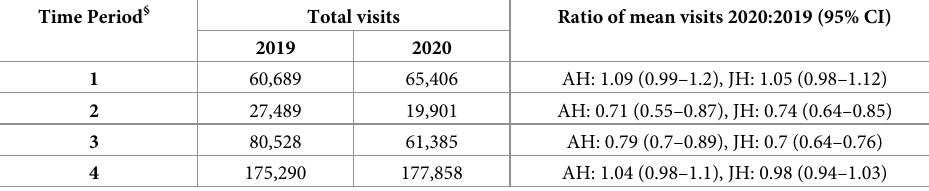
Table 2. Total ambulatory visits (for Allegheny Health (AH) and Johns Hopkins (JH),